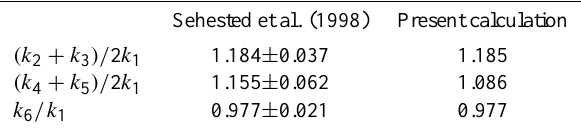
Fig. 7. Calculated enhancements in the different isotopically substi- tuted ozone molecules (from 17 O 16 O 16 O to 18 O 18 O 18 O; mass 49 to 54) are compared with experimental data (Morton et al., 1989).